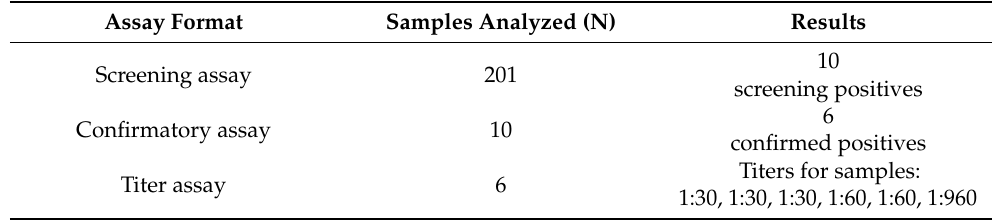
Table 13. Brief summary of sample